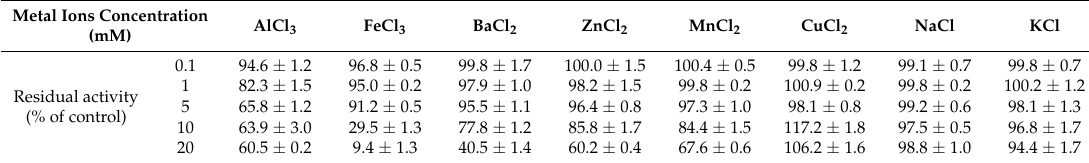
Table 3. Effect of metal ions on PHTI.